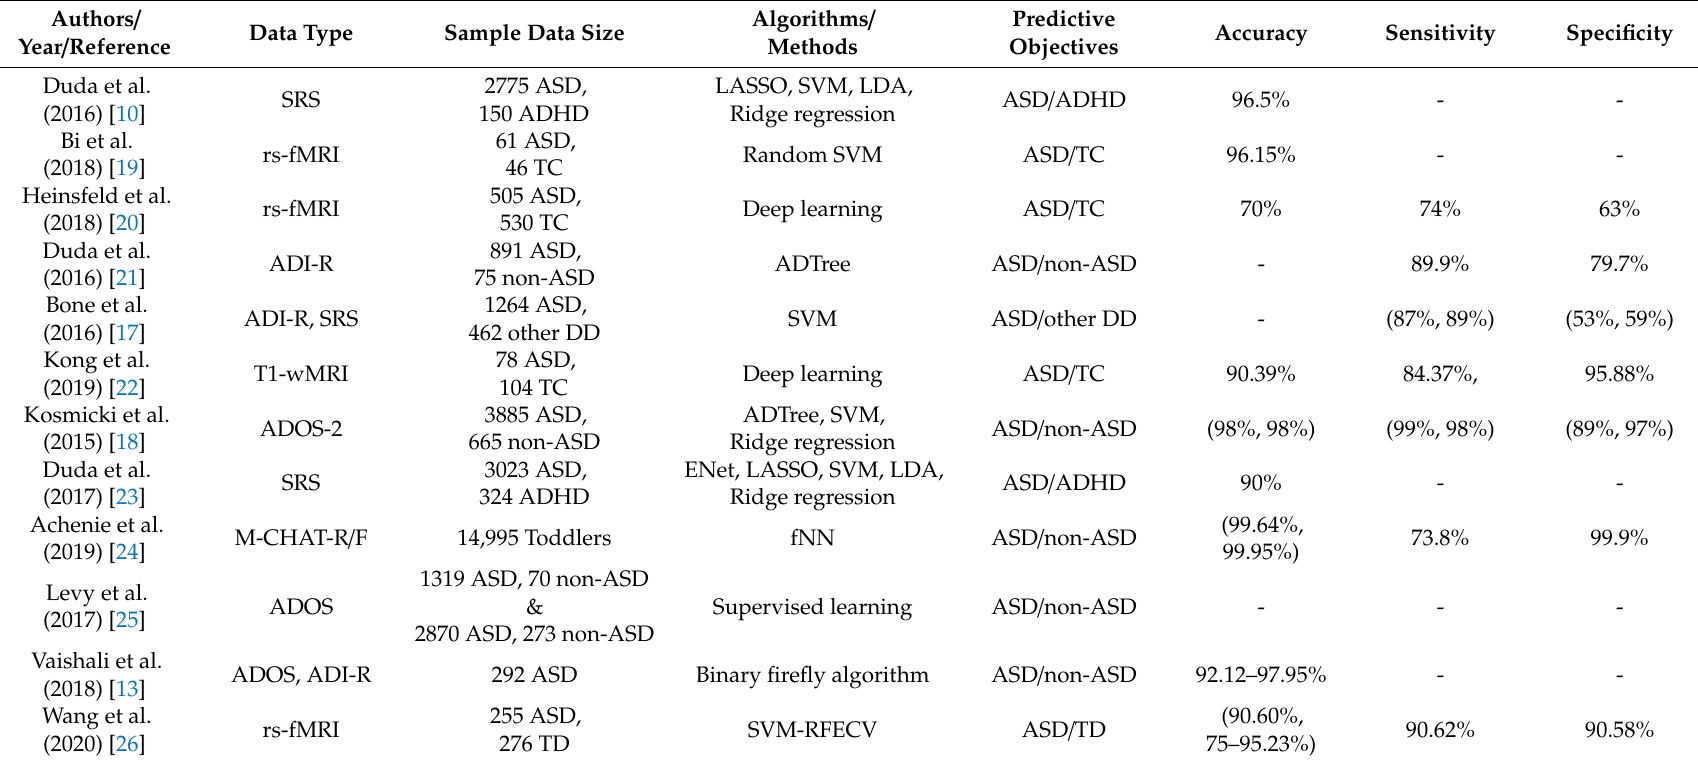
Table 3. Summary of relevant works that utilized machine learning algorithms for the classification of